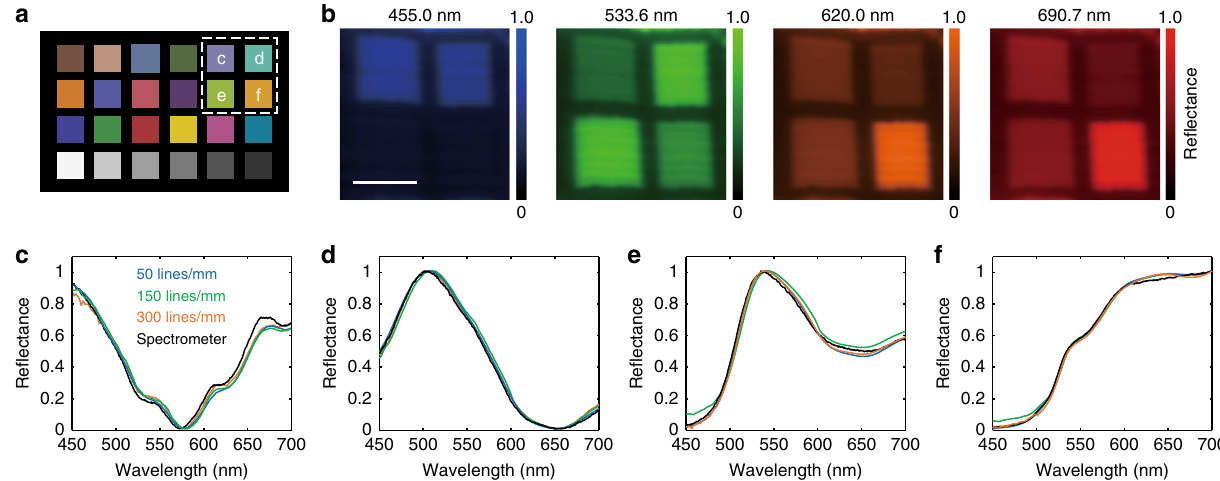
Fig. 5 HySE exhibits excellent colour fi delity. a Schematic of colour samples interrogated in a Macbeth Colour Checker. b Representative slice images of the hypercube in the region of the white dashed line in a at four wavelengths. c – f Normalised re fl ectance intensity pro fi les of the four colour samples indicated by c – f in a . Black line indicates ground-truth re fl ectance signals recorded by a calibrated spectrometer. Blue, green and orange lines are re fl ectance signals in the hypercube measured by three different gratings (50, 150 and 300 lines/mm), respectively. Images acquired using external illumination. Scale bar = 1 mm